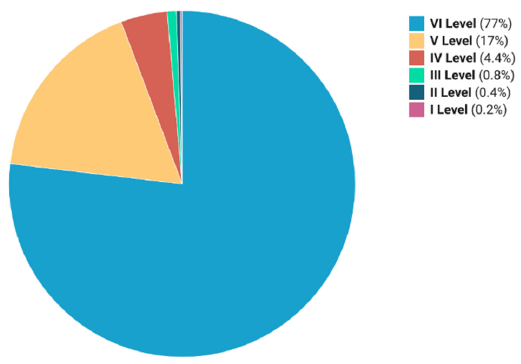
Figure 6. Urban spatial linkage networks grade chart.